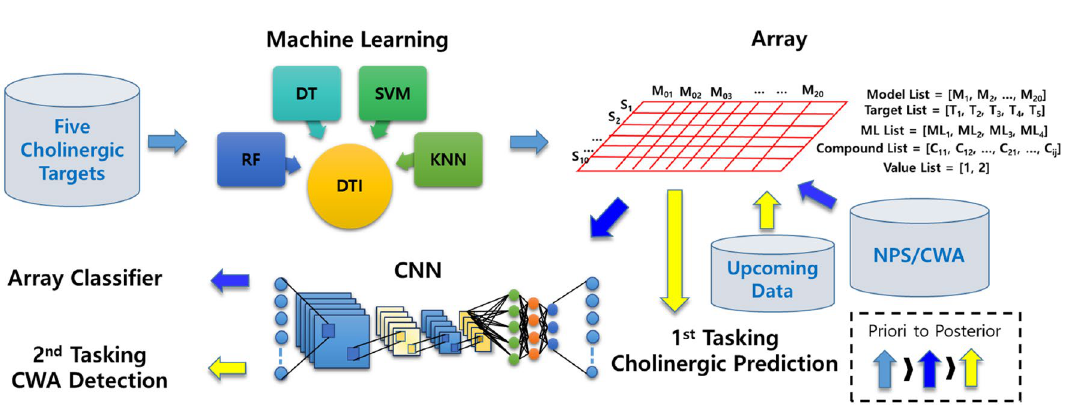
Figure 4. Design of meta-predictor for multi-tasking and data workflow. Pale sky-blue arrow: data flow for building cholinergic DTI models, blue arrow: data flow for building array classifier, yellow arrow: the flow of upcoming data for multi-task. Model list = [M1, M2, …, M20], target list = [T1, T2, T3, T4, T5], ML list = [ML1, ML2, ML3, ML4], seed list = [S1, S2, …, S10], compound list = [C11, C12, …, C21, …, Cij], and value list of predictors = [1,